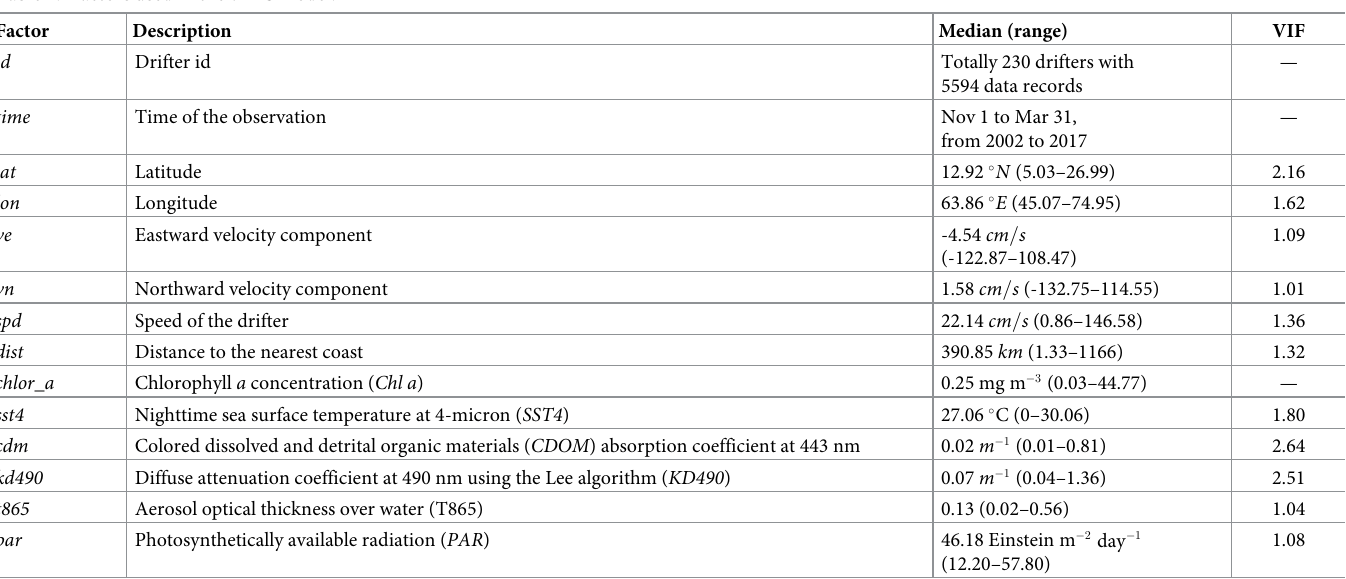
Table 1. Factors used in the vLDS